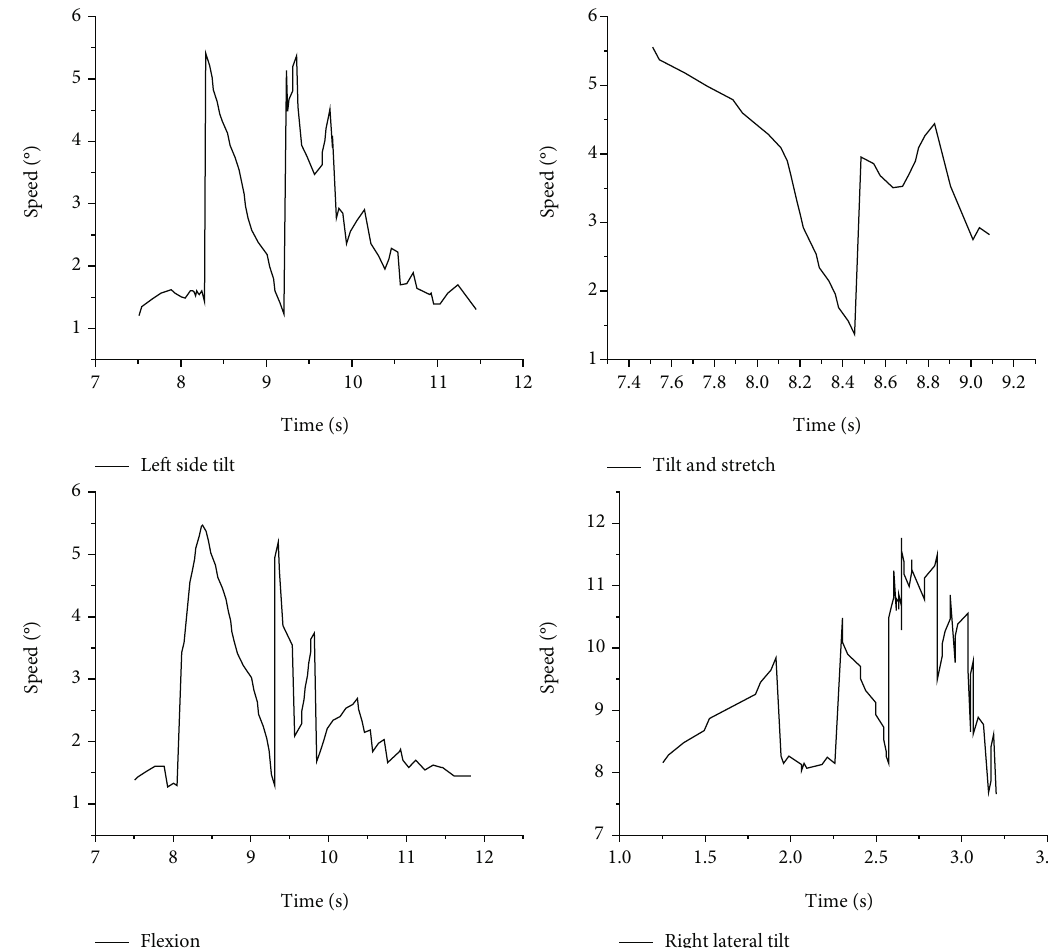
Figure 5: Speed time diagram of the second experiment of cervical spine angle measurement with the hybrid depth camera-VR